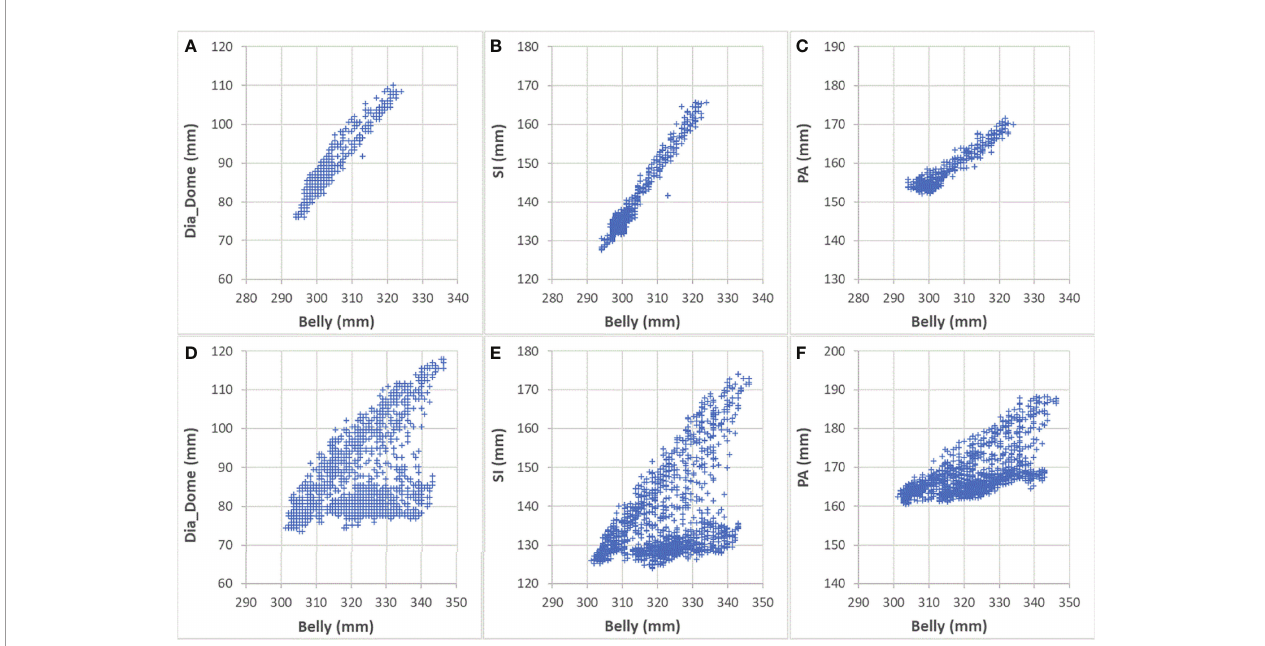
FIGURE 6 | Comparing correlations with Belly for Sessions #3 and #4 of patient LV13. (A) Dia_Dome as a function of Belly in Session #3; (B) SI as a function of Belly in Session #3; (C) PA as a function of Belly in Session #3; (D) Dia_Dome as a function of Belly in Session #4; (E) SI as a function of Belly in Session #4; (F) PA as a function of Belly in Session #4.